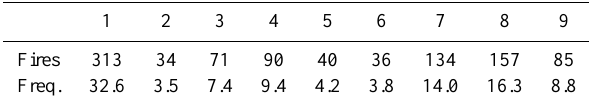
Table 2. Number of wildfires per lightning event in the provinces of Castile and Leon between 1987 and 2006.